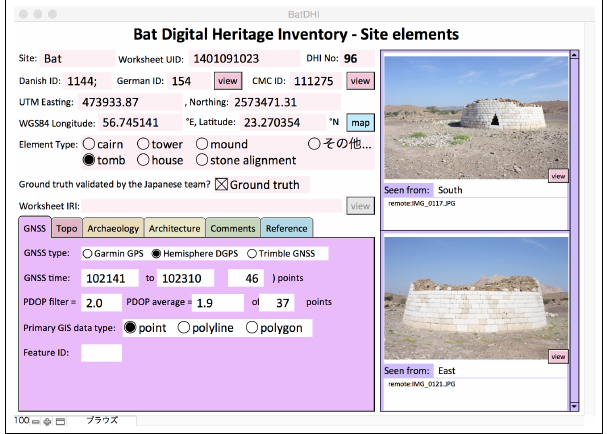
Figure 4: Interface of the ElementDHI table (GNSS tab).